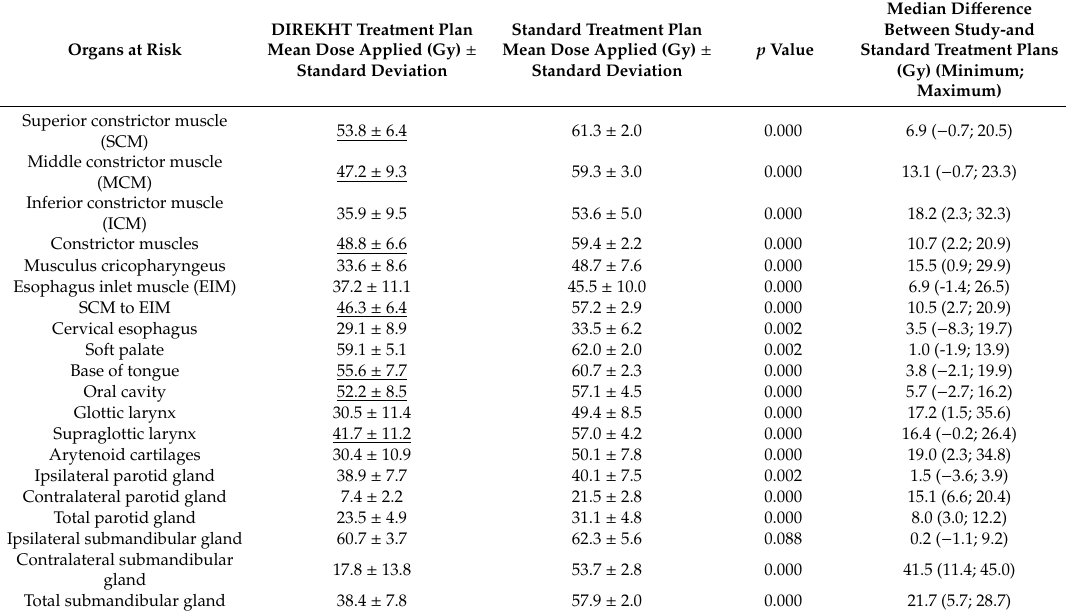
Table 2. Mean doses applied in swallowing apparatus and major salivary glands in study treatment plan compared to standard treatment plan (Organs at risk in which a mean dose of < 56 Gy is applied in study but not in standard treatment plans are